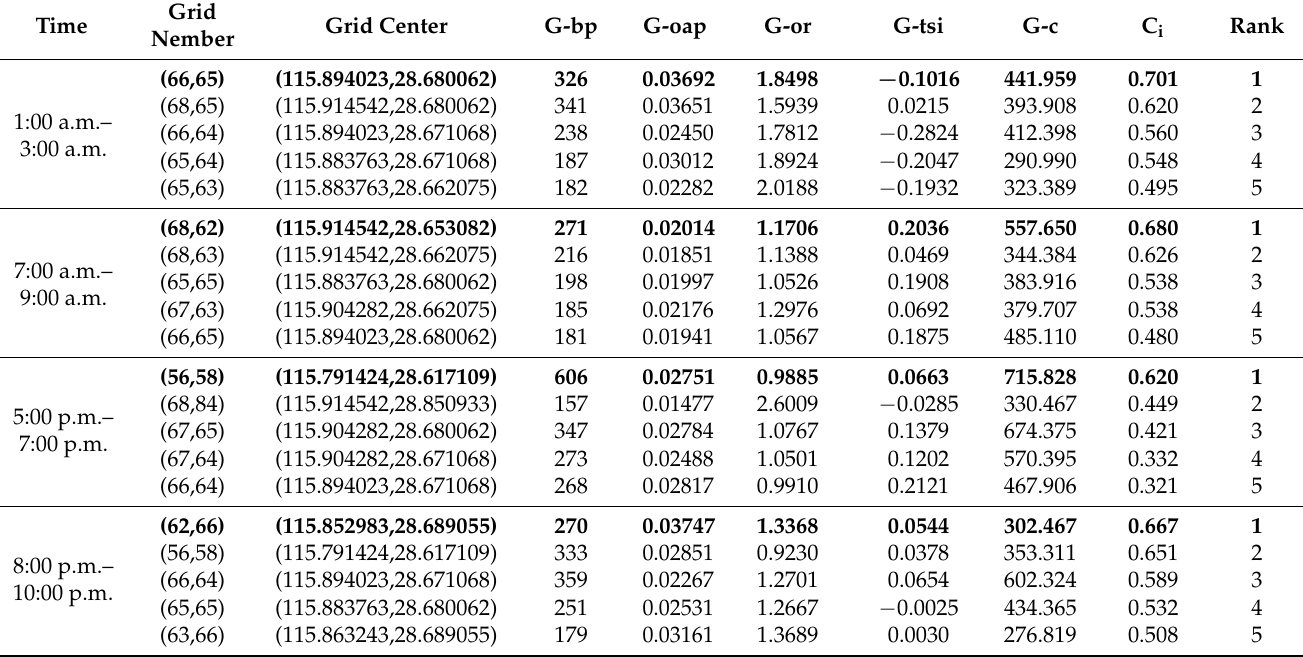
Table 6. Weighted grid value ranking for each time period(The bold part is the relevant indicators of the grid area that ranks first in the comprehensive hotspot during the period).